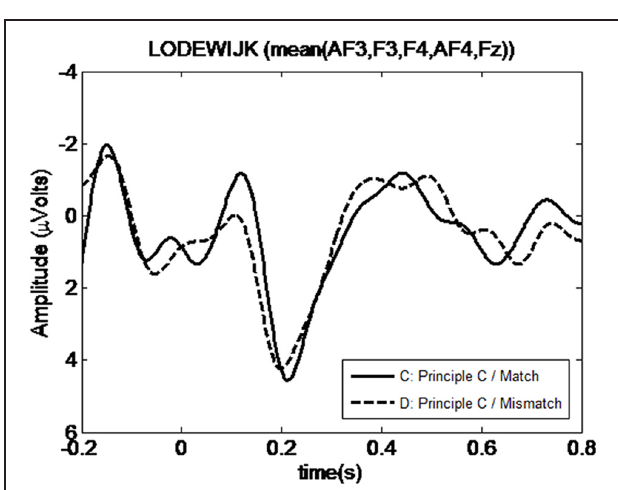
FIGURE 4 | Topographic scalp maps of the difference wave between the Principle-C Mismatch and the Principle-C Match condition at a series of discrete time